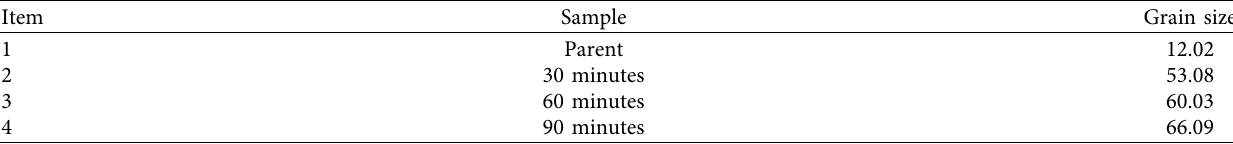
Figure 4: Microstructural images of different samples: (a) parent, (b) 30mins, (c) 60mins, and (d) 90mins. Table 3: Average grain size measurement for Cp-Ti grade 2 samples ( μ m).